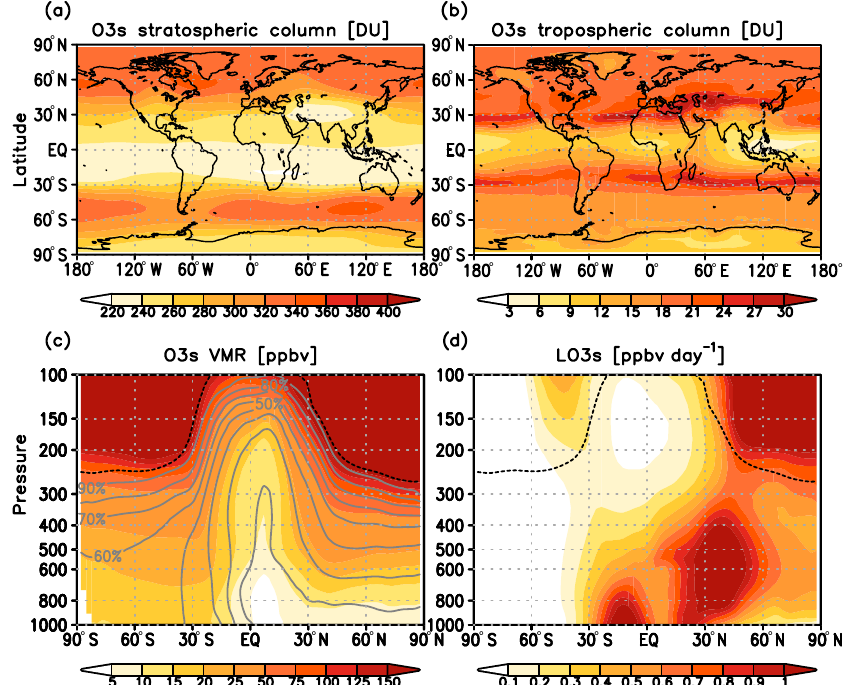
Figure 3. (a) Geographical distribution of stratospheric partial columns of the diagnostic O 3 s tracer in Dobson units (DU) in June for the REF2000 simulation. (b) Same as (a) but for tropospheric columns. (c) Latitude–height section of the O 3 s volume mixing ratios [ppbv] and (d) latitude–height section of the chemical loss rate of O 3 s [ppbvday − 1 ]. The black dashed line indicates the position of the mean tropopause. Gray contour lines in (c) show the relative contribution of O 3 s to the ozone field in